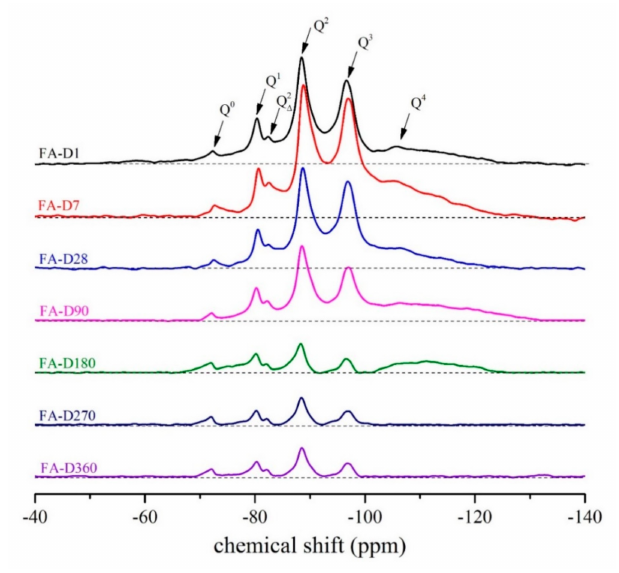
Figure 10. 29 Si NMR spectra of the geopolymer pore solutions at ages between 1 day and 1